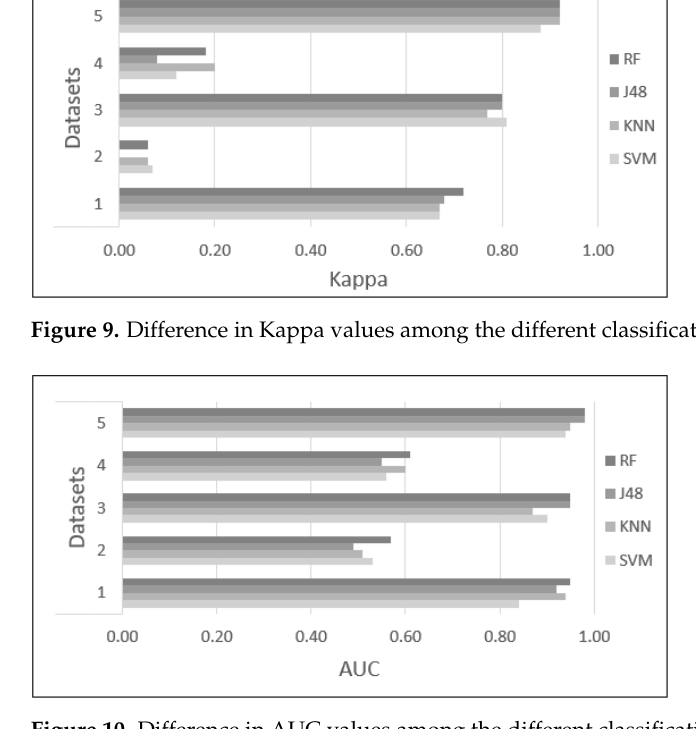
Figure 10. Difference in AUC values among the different classification